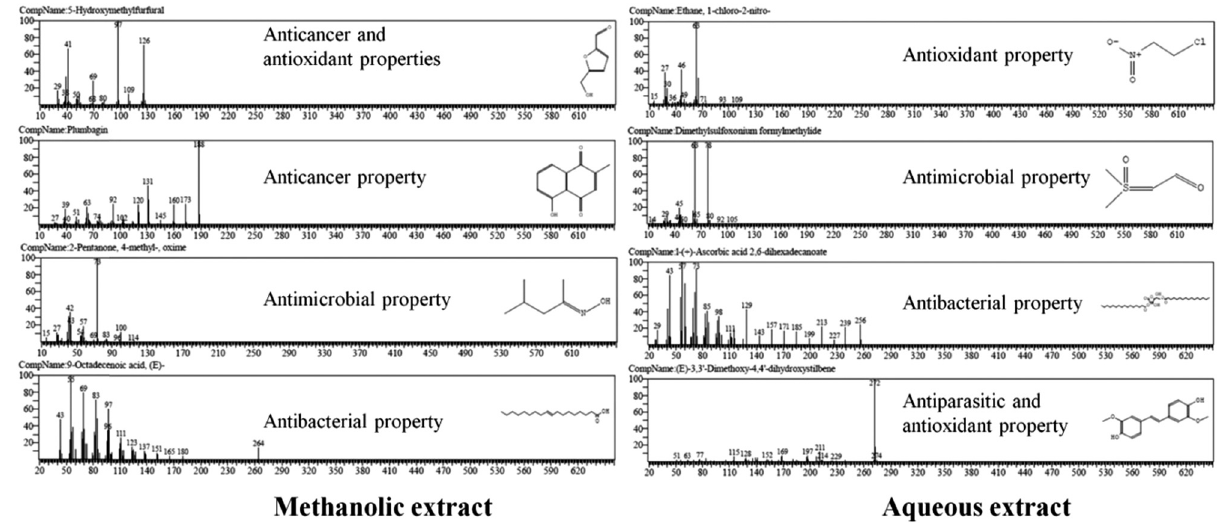
Figure 2: Structures and mass spectra of compounds identi fi ed by mass spectrometer in methanolic and aqueous root extracts of P. indica